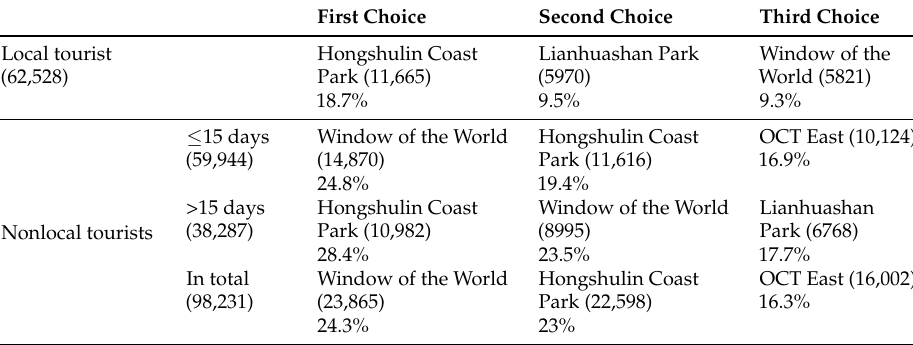
Figure 3. Distribution and statistics of user origin at tourist attraction with >3000 check-ins. Table 2. Tourists’ choice of scenic spots from different tourist markets.